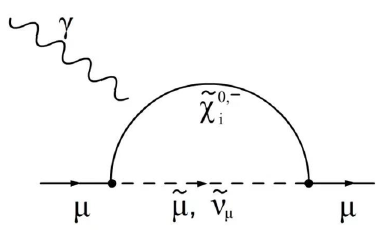
Figure 1 . The one-loop contributions arise from Feynman diagrams where the muon lepton number is carried by ˜ µ or ˜ ν .The external photon can couple to each charged particle. µ